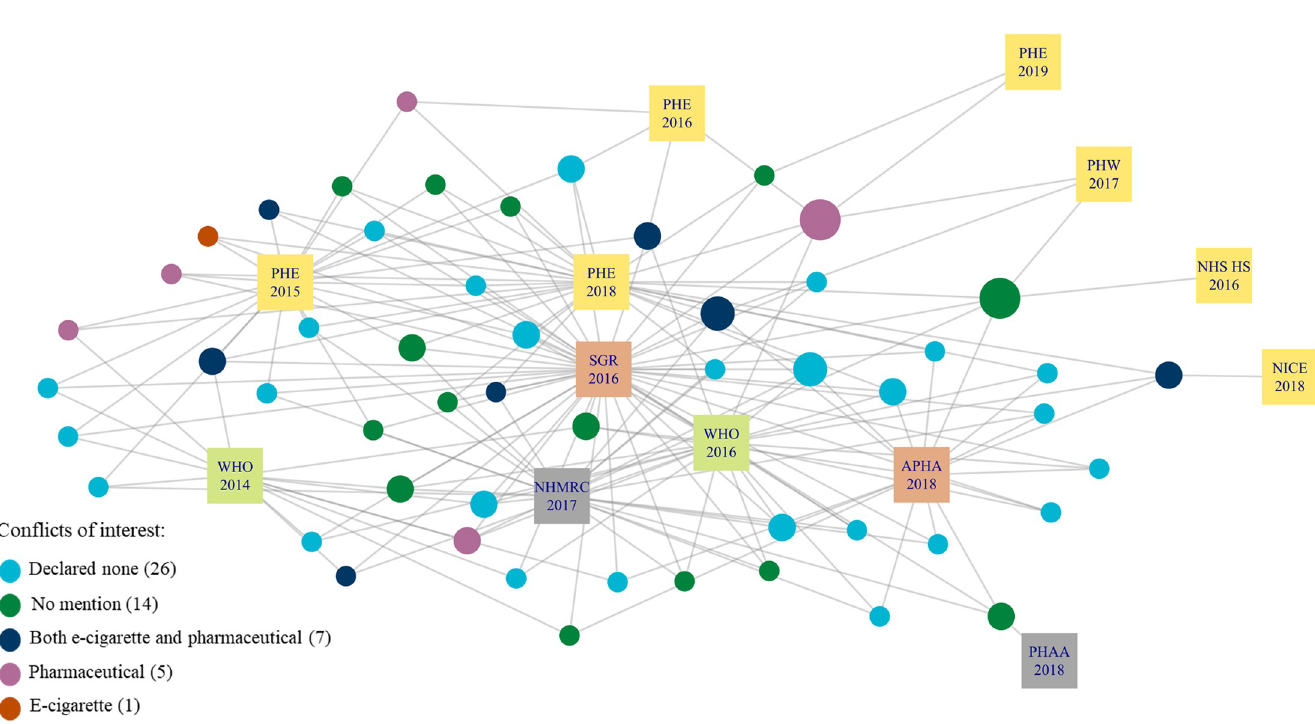
Fig 4. Citation network showing the conflicts of interest of the 53 highly cited citations across 13 recommendation documents. APHA = American Public Health Association; NHMRC = National Health and Medical Research Council (AUS); NHS HS = NHS Health Scotland; NICE = National Institute for Health and Care Excellence (UK); PHAA = Public Health Association Australia; PHE = Public Health England; PHW = Public Health Wales; SGR = U.S. Department of Health and Human Services: A Report of the Surgeon General.